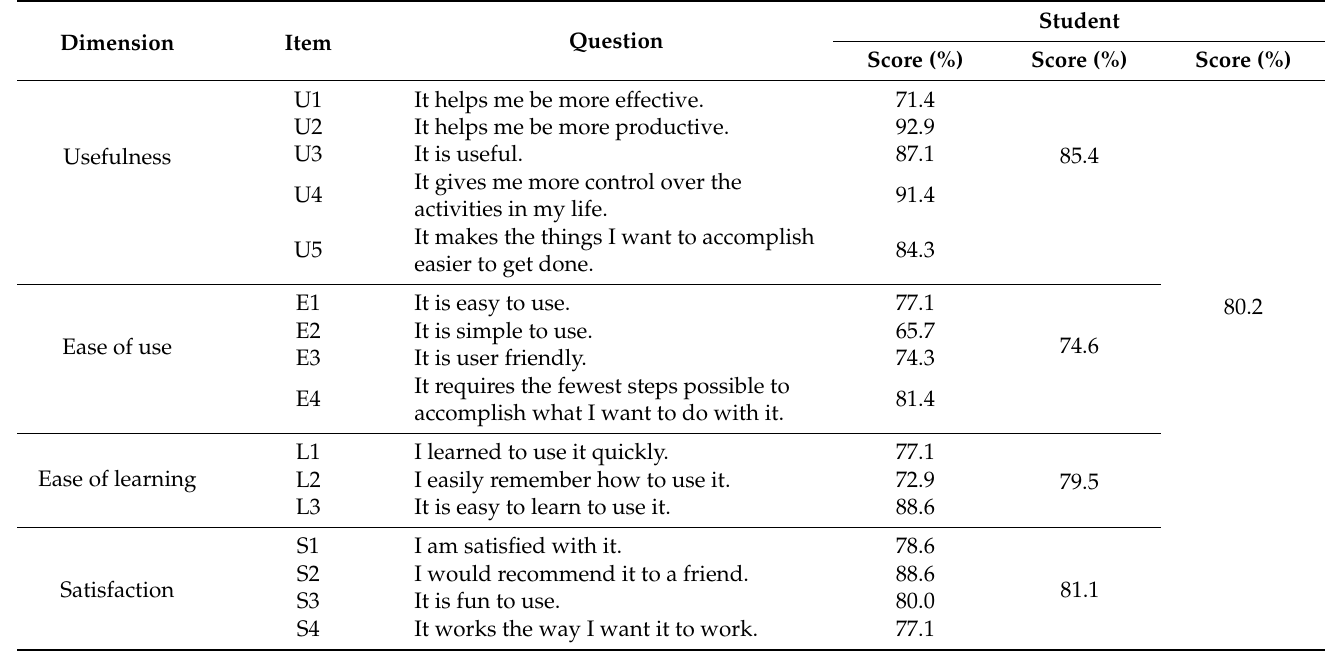
Table 7. USE survey result conducted on instructors and